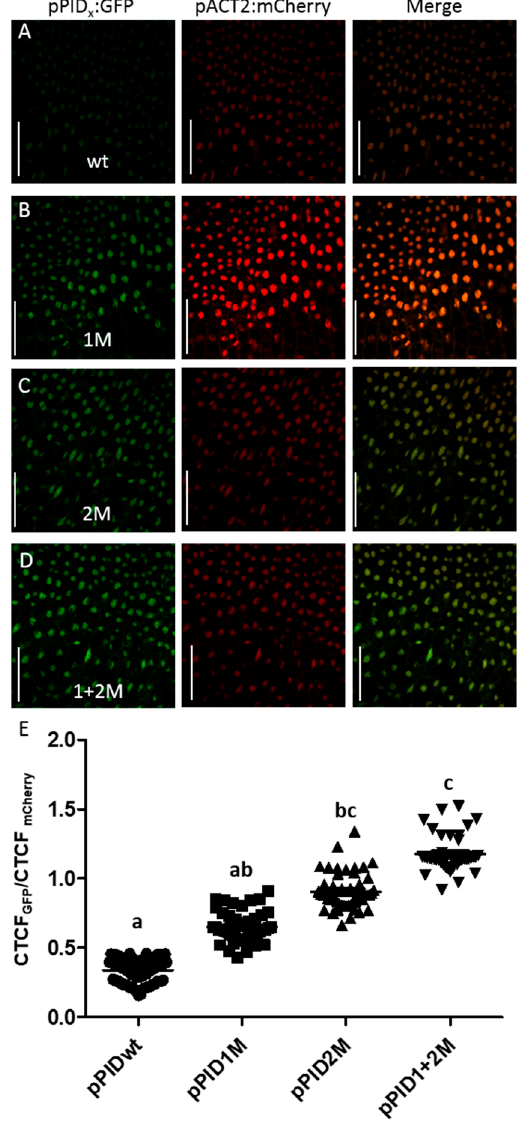
Figure 2. Mutating AuxREs a ff ect PID promoter activity in the style region. ( A – D ) Representative confocal images of the style region of stage 12 for the respective promoter variant reporter lines. Scale bars = 50 µ M ( E ) Fluorescence quantification shows that mutating AuxREs lead to a gradual activation of the PID gene. The data indicate that the two AuxREs have an additive e ff ect (N = 40). a,b,c indicate significant di ff erences according to multiple comparison.